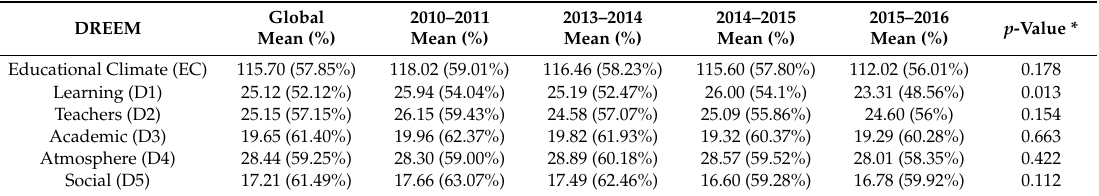
Table 1. Mean values (%) of the ‘Educational Climate’ and the domains of the Dundee Ready Education Environment Measure (DREEM) questionnaire based on academic years.